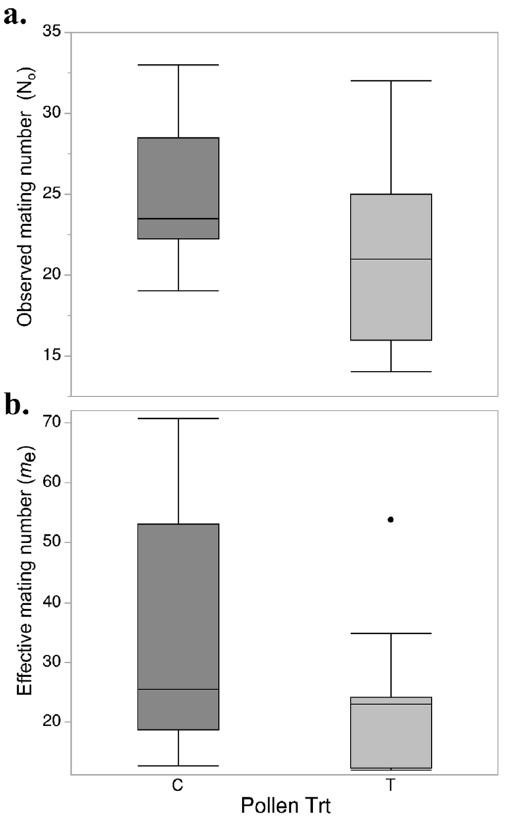
Figure 3. Observed mating number ( a ) and effective mating numbers ( b ) for queens reared in treated (T) (n = 11 queens) and control (C) (n = 12 queens)